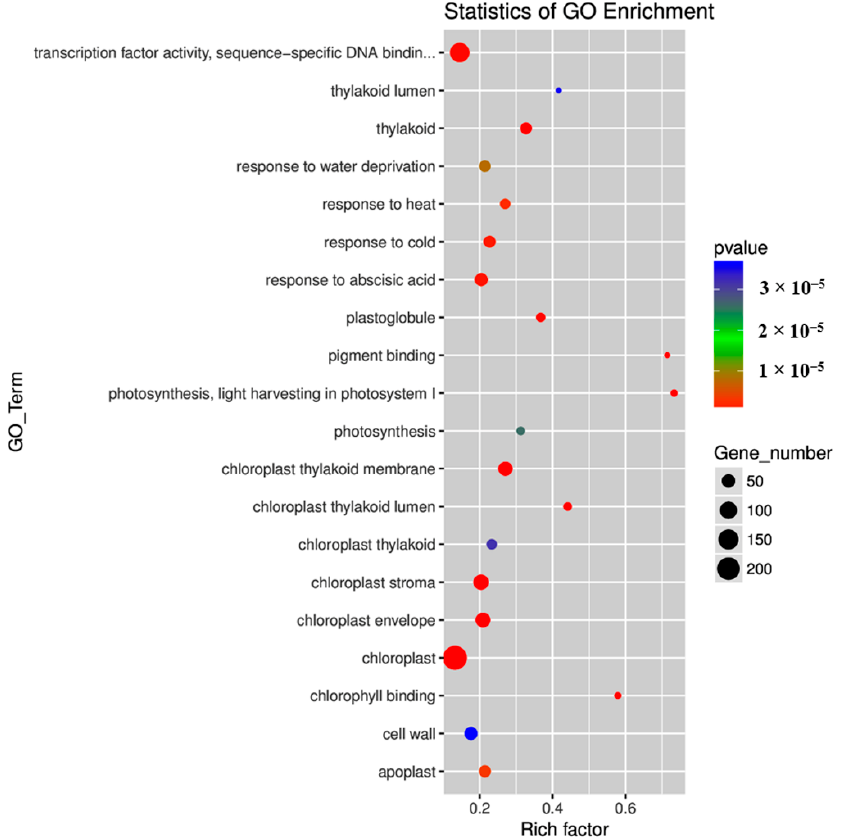
Figure 4. Top 20 gene ontology (GO) terms enriched for different expressed genes. The size of each circle represents the number of significantly differentially expressed genes enriched in the corresponding term. The enrichment factor was calculated using the number of enriched genes divided by the total number of background genes in the corresponding pathway. The p -value was calculated using the Benjamini–Hochberg correction. A term with p < 0.05 is considered significantly overrepresented.